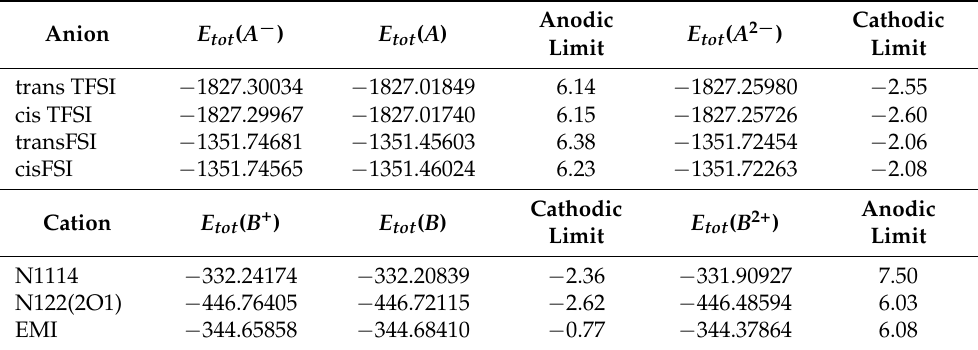
Table 4. Electronic energy (in atomic units) of anions and cations and their unrelaxed neutral or double charged forms calculated at the B3LYP/6-31G** level of theory, including empirical dispersion forces in a polar medium and derived anodic and cathodic limit (V).